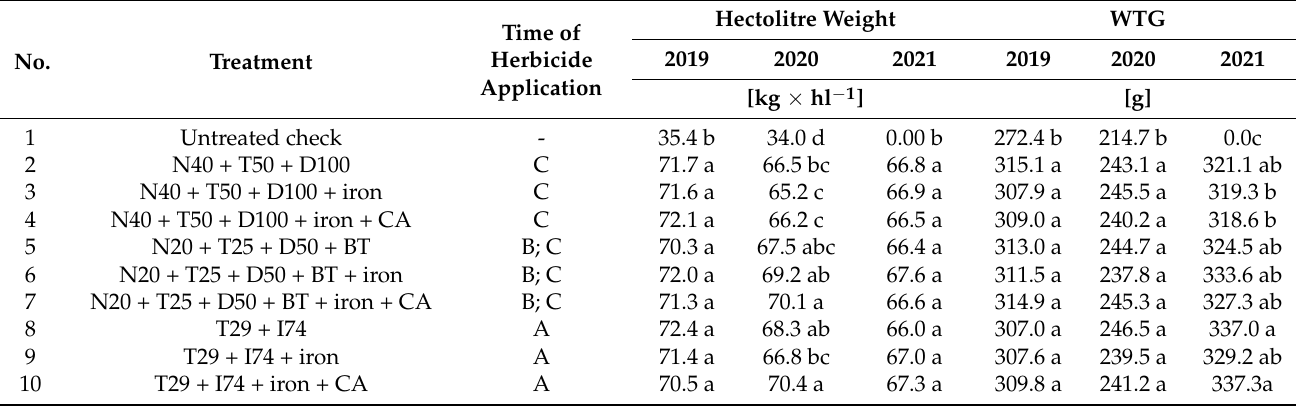
Table 8. Impact of dose and time application on hectolitre weight and weight of a thousand